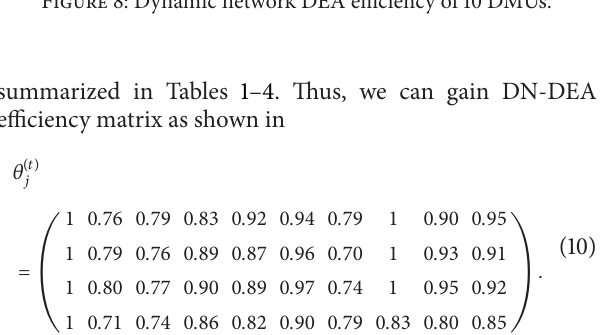
Figure 7 reflects the dynamic fluctuation of network DEA efficiency for each DMU over the four time periods, from which we can conclude that the network DEA efficiency of the observed time periods vibrates irregularly. We apply model (9) for the sake of evaluating the overall dynamic network efficiency of DN-DEA on the basis of the DEA structure proposed in Figure 5. The overall dynamic network efficiency and ranking sequence of DN-DEA can be finally provided in Table 5, which can be compared in Figure